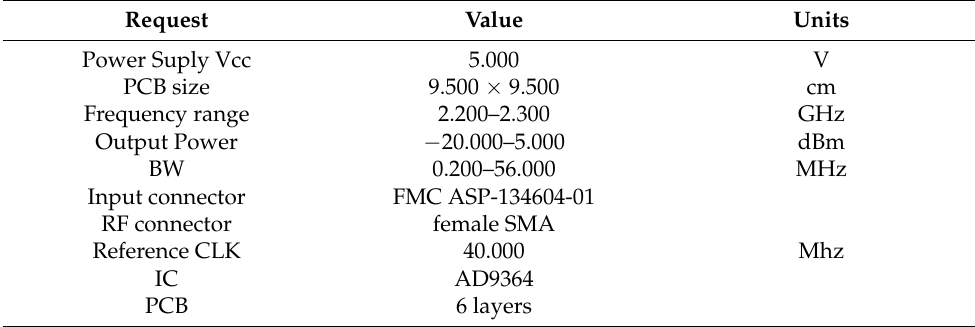
Table 1. General requirements of the RABE.